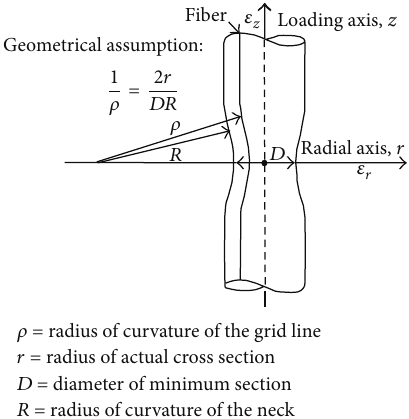
Figure 2: Illustration of necking of a round specimen and intro- duction of parameters and geometrical assumption employed in this